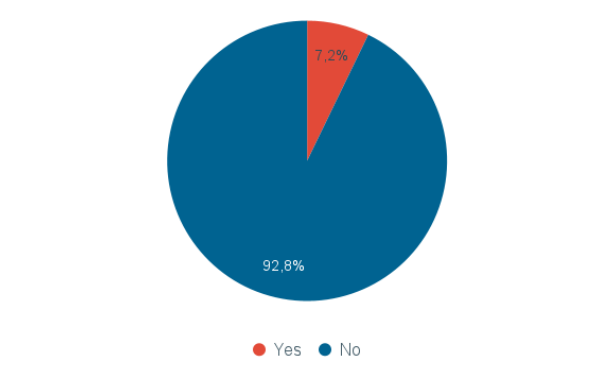
Figure 20. Did you know Carol Shaw before the game? - Test 2.